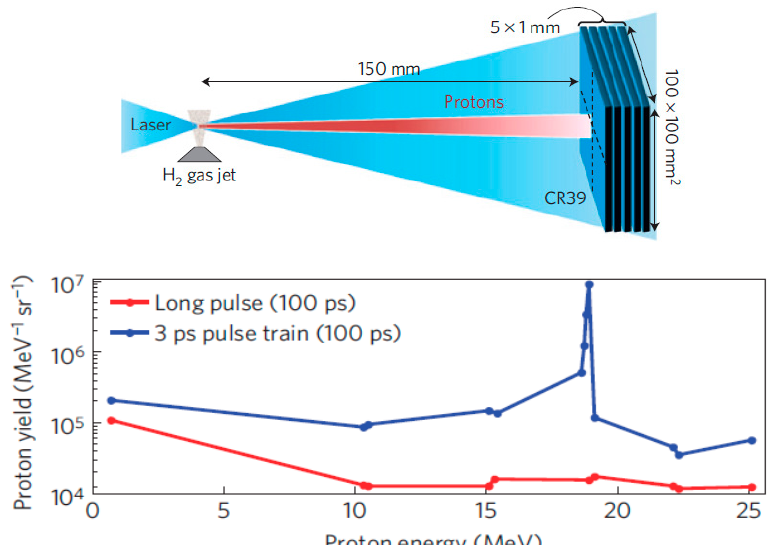
Figure 8. A linear polarized train of multiterawatt CO 2 laser pulses interacting with a gas jet. The laser with an intensity of 6.5 × 10 16 W·cm − 2 produces a monoenergetic peak at about 20 MeV. With an intensity of 7 × 10 19 W·cm − 2 computer simulations showed the peak energy increased to ~170 MeV closer to the energy needed for proton